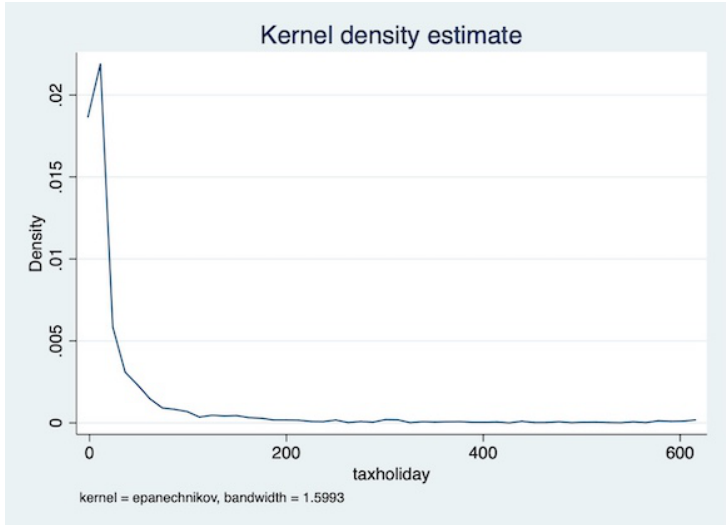
Figure A1. Tax Holiday Distribution.